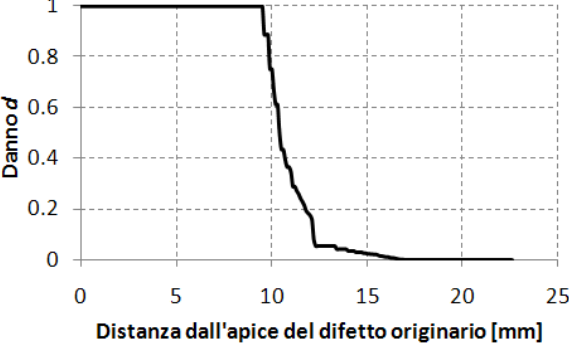
Figura 11: Distribuzione della variabile di danno d in funzione della distanza dall’apice del difetto. Fig. 11 mostra l’andamento della variabile danno in funzione della distanza dell’apice del difetto originale, quando la zona